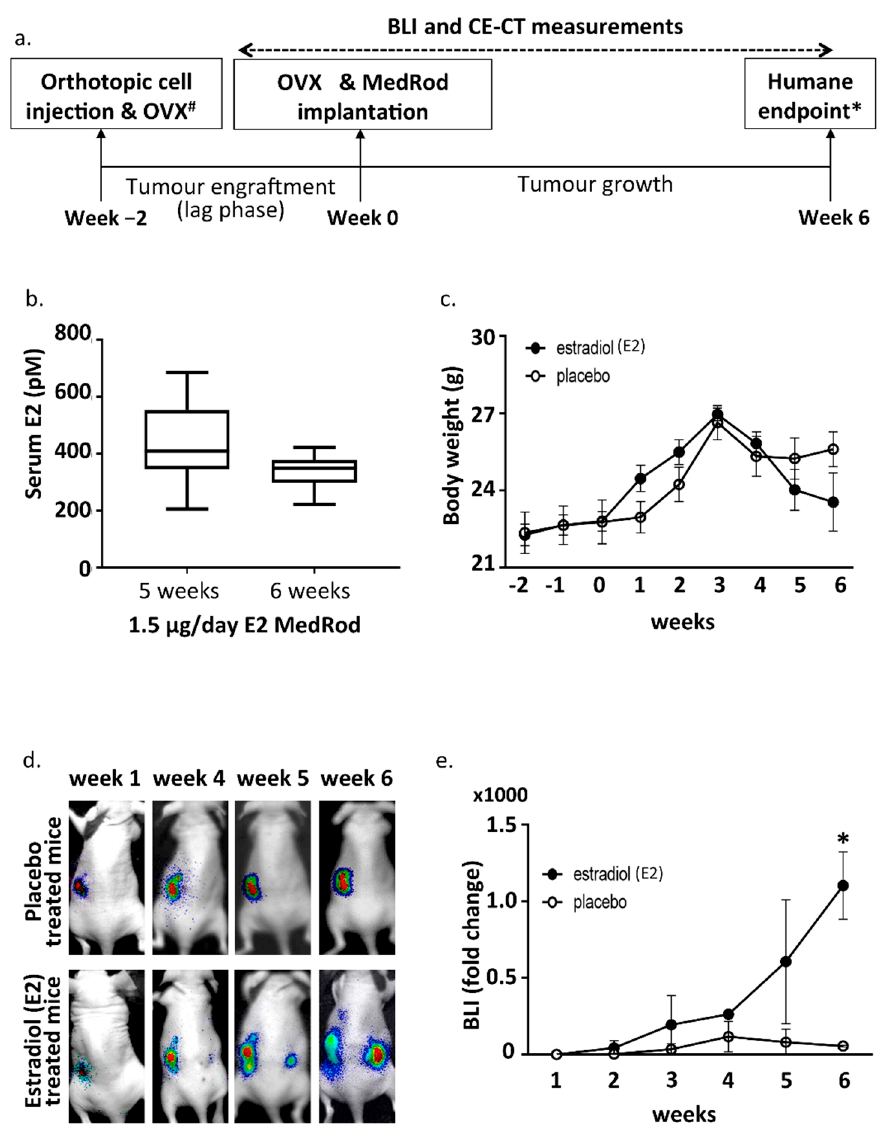
Figure 1. Experimental design and bioluminescence (BLI) results. ( a ) Timeline of the mouse model. Tumors were induced by orthotopic cell injection in one horn of the uterus (week 2). At the same time, ipsilateral OVX was performed. Two weeks later (i.e., at the end of the lag phase; week 0) OVX was performed at the other uterine horn as well and the MedRod delivery system for E2 or placebo was supplementation was implanted subcutaneously. Tumor growth was monitored weekly by BLI until the humane endpoint was reached. Before euthanasia CE-CT was performed. # Ipsilateral OVX and OVX was not performed in the first experiment testing the cell titer. * Humane endpoint: signs of discomfort due to large-sized tumours. ( b ) Serum E2 concentration (LC-MS/MS) in mice implanted with MedRod devices releasing 1.5 μ g/day of E2. Boxplots indicate the median and the lower and upper quartiles. Blots represent data from nine (5 weeks) and 12 mice (6 weeks) per time point. ( c ) Body weight. Mean values and standard deviations are shown (placebo: 8 mice; E2: 8 mice). ( d ) Representative images of in vivo sequential BLI. Note that the BLI signal from the location of primary tumour induction tends to decrease at late time points due to necrosis of the tumour tissue (as assessed histologically). ( e ) BLI fold change during the experiment. Shown data refers to the experiments with the Ishikawa clone three. Similar data was obtained with the other cell clones (data not shown). Mean values and standard deviations are shown (placebo: 3 mice; E2: 2 mice). Asterisk (*) indicates a p -value < 0.05 ( t -test).